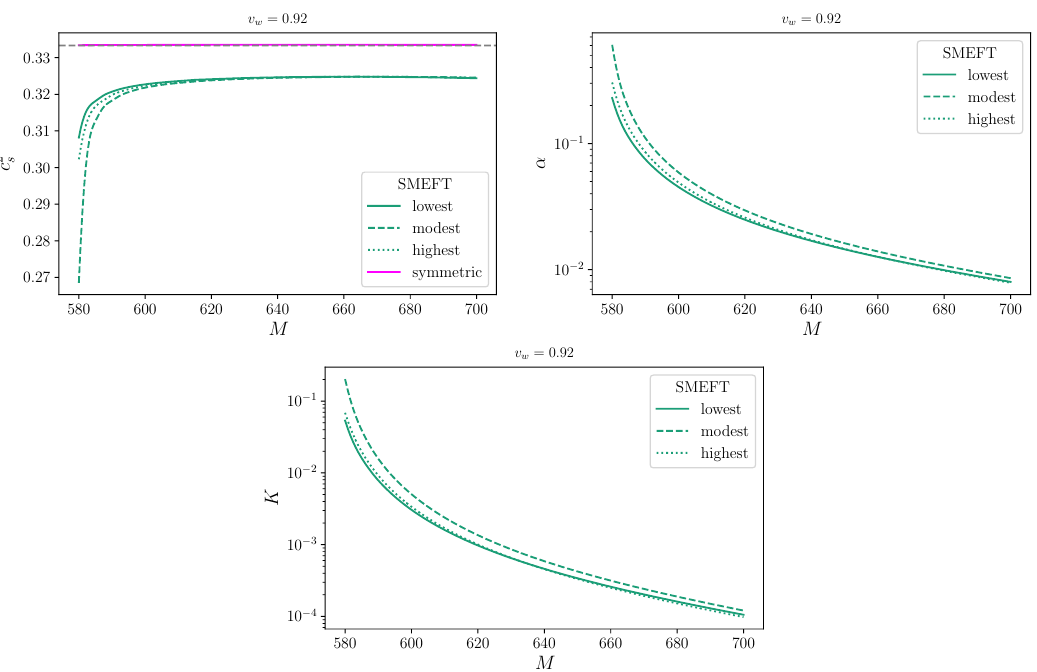
Figure 4 . SMEFT : the top left panel shows the speed of sound calculated in the symmetric and broken phase using eq. (2.47) at the different levels of diligence. The gray dashed line corresponds to the bag model with c 2 = 1 / 3 . The symmetric phase (solid magenta) is only shown at highest s diligence. The top right panel shows the strength of the phase transition at the different levels of diligence using eq. [(2.5), (2.12), (2.49)]. The bottom panel shows the kinetic energy fraction at the different levels of diligence where the lowest and modest diligence use fits for κ to get K and the highest diligence uses eq. (2.55). The temperatures are set to T (2.4), T (2.11), and T (2.27) for n p f the lowest, modest, and highest diligence respectively. The numerical calculation of the speed of sound only enters in the highest diligence of α